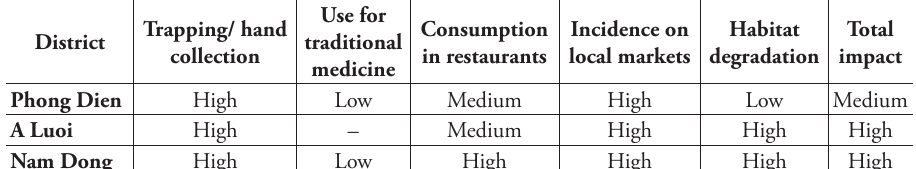
Table 3. Impacts on Physignathus cocincinus at study sites based on interview data and own observations.